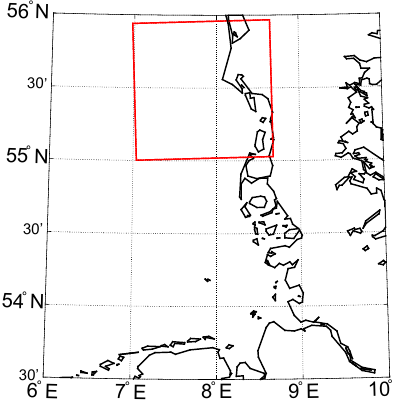
Figure 1. Example wind speed time series of the offshore met mast Fino 1 (a) and resulting wind power time series by using a power curve of an offshore turbine (b) . The power is normalized with the maximum power.